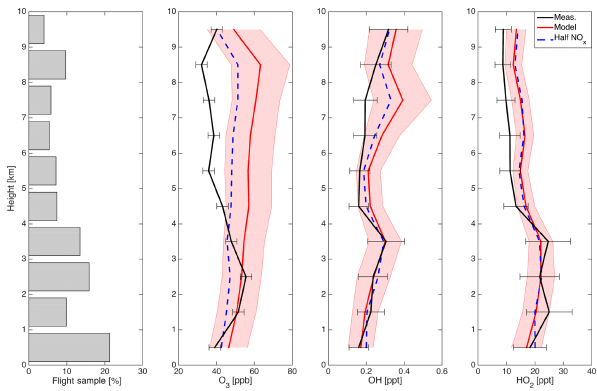
Figure 10. Vertical profiles of median modeled (red) and measured (black) ozone, OH, and HO 2 INTEX-A flight data binned by kilo- meter. Gray bar graph shows percent of flight data within each ver- tical bin. Shaded regions represent 1 σ of the model ensemble; error bars on measurements are uncertainty at 1 σ confidence. Blue line represents EPA-NEI and lightning NO x emissions reduced by 50%.